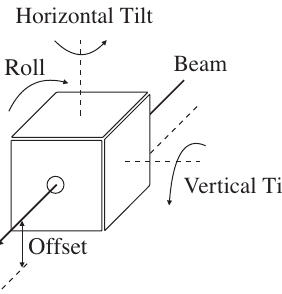
FIG. 6. Illustration of different types of misalignments: roll, tilt, and offset. In each case, the dashed line is the